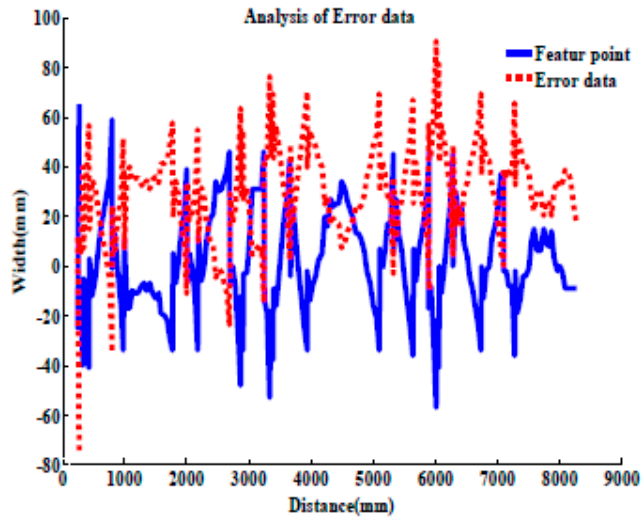
Figure 14. The analysis of error data.